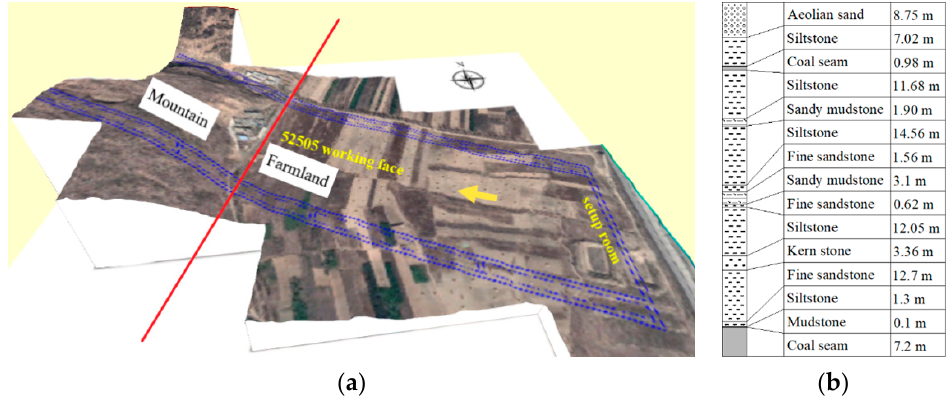
Figure 6. Surface topography above the working face and the drilling histogram of working face: ( a ) surface topography and landform of panel; ( b ) borehole columnar section.